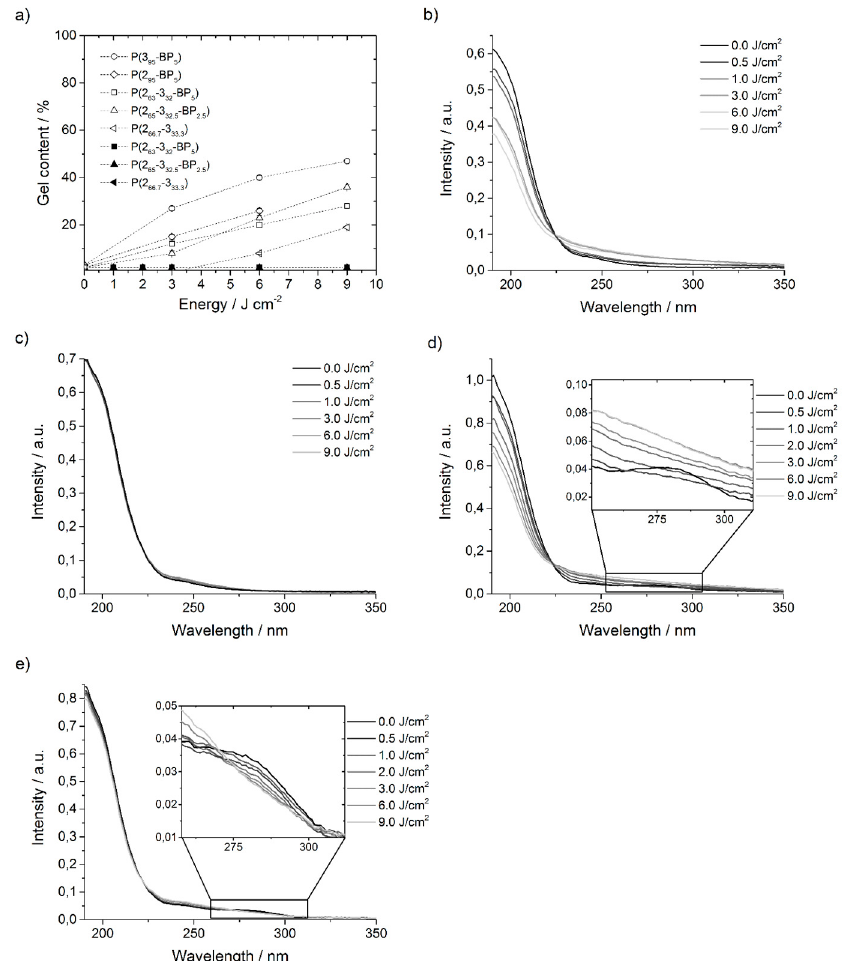
Figure 4. ( a ) Gel content of polymer networks consisting of different versions of P(2-3-BP) as a function of the irradiation energy, irradiated at λ = 254 nm (open symbols, Table S7) and λ = 365 nm (filled symbols, Table S6), P(3 95 -BP 5 ) = ( M1 / M2 / M3 5:0:95), P(2 95 -BP 5 ) = ( M1 / M2 / M3 5:95:0), P(2 63 -3 32 -BP 5 ) = ( M1 / M2 / M3 5:63:32), P(2 65 -3 32.5 -BP 2.5 ) = ( M1 / M2 / M3 2.5:65:32.5) and P(2 66.7 -3 33.3 ) = ( M1 / M2 / M3 0:66.7:33.3). ( b – e ) UV absorption spectra of P(2 66.7 -3 33.3 ) films irradiated at ( b ) 254 nm and ( c ) 365 nm and of P(2 65 -3 32.5 -BP 2.5 ) films irradiated at ( d ) 254 nm and ( e ) 365